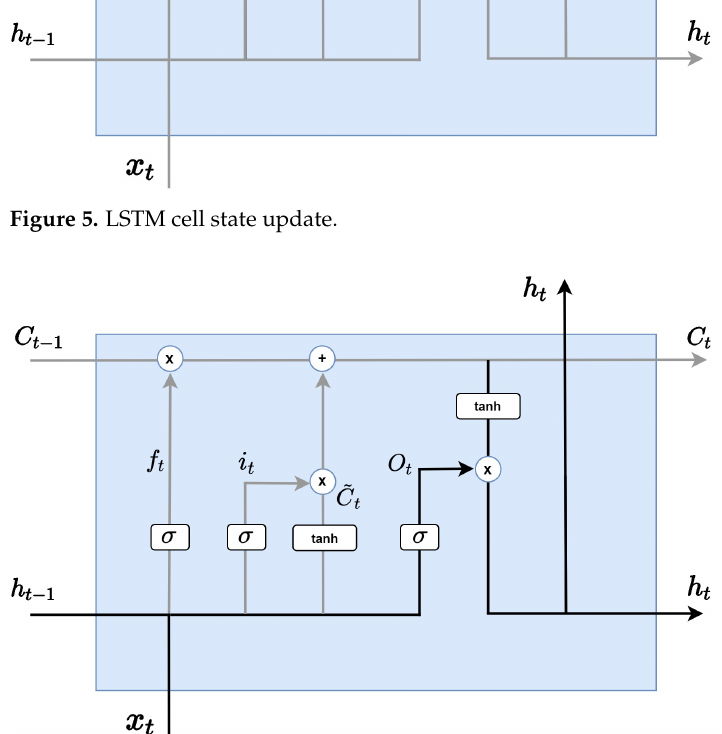
Figure 6. LSTM output gate